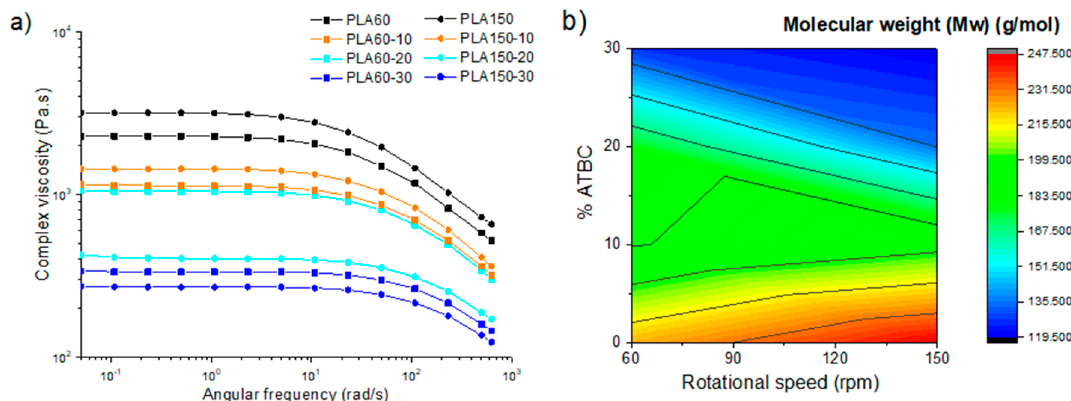
Polymers 2018 , 10 , x FOR PEER REVIEW 10 of 26 Figure 5. Rheological characteristics: ( a ) complex viscosity and ( b ) molecular weight calculated from the rheological data of PLA and PLA with ATBC at 10, 20 and 30% extruded to 60 and 150 rpm.